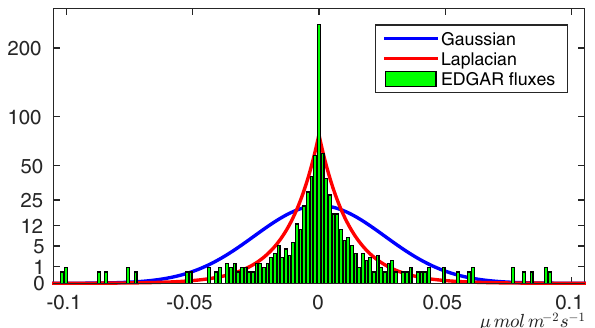
Figure 5. Normalized histogram of randomly signed EDGAR fluxes. The histogram data have been used to estimate the parameters of corresponding Gaussian and Laplacian probabil- ity density functions. Note that only 10 grid cells have emis- sions larger than 0.1µmolm − 2 s − 1 , with the largest one reaching 0.29µmolm − 2 s − 1 . Even though the center bin is largely popu- lated, only less than 10% of all fluxes are equal to